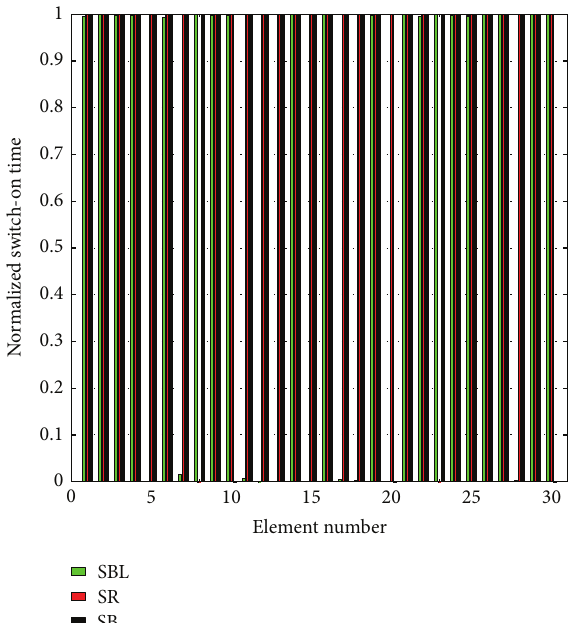
Figure 5: Switch-on time durations of the best converged solution for IS.